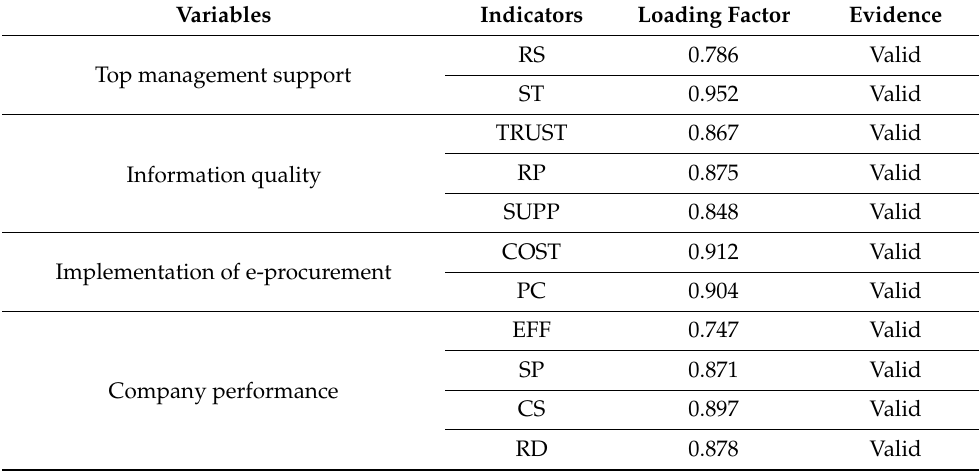
Table 4. Validity Table 4. Validity test.